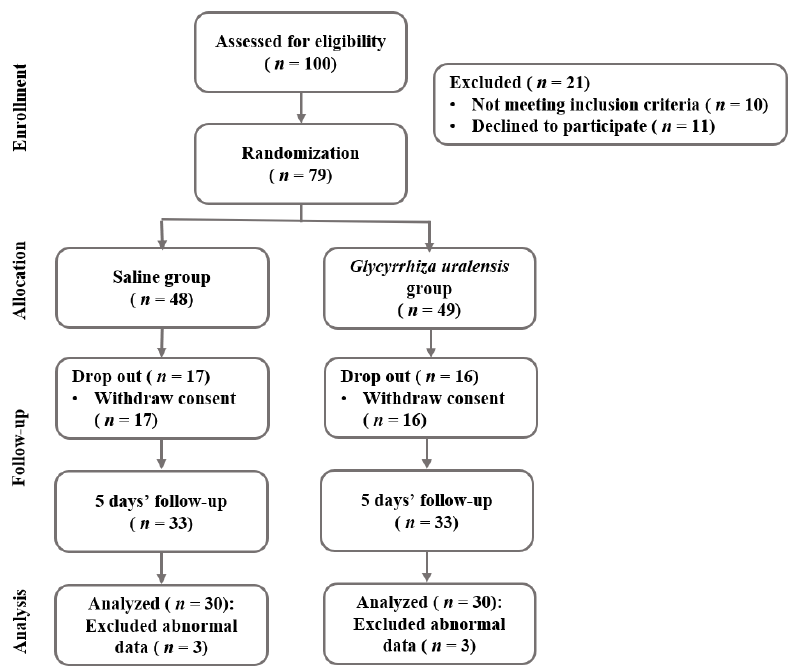
Figure 1. Research flow diagram.